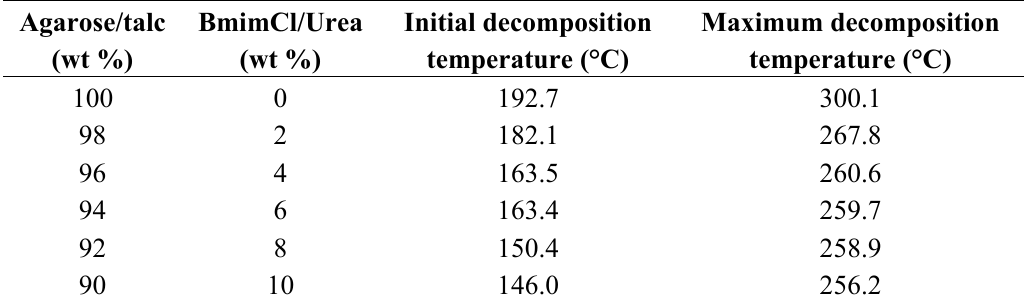
Table 2. The initial and maximum decomposition temperature obtained from thermogravimetric analysis (TGA) and derivative thermogram (DTG) of the agarose/talc Initial decomposition Maximum temperature (°C)